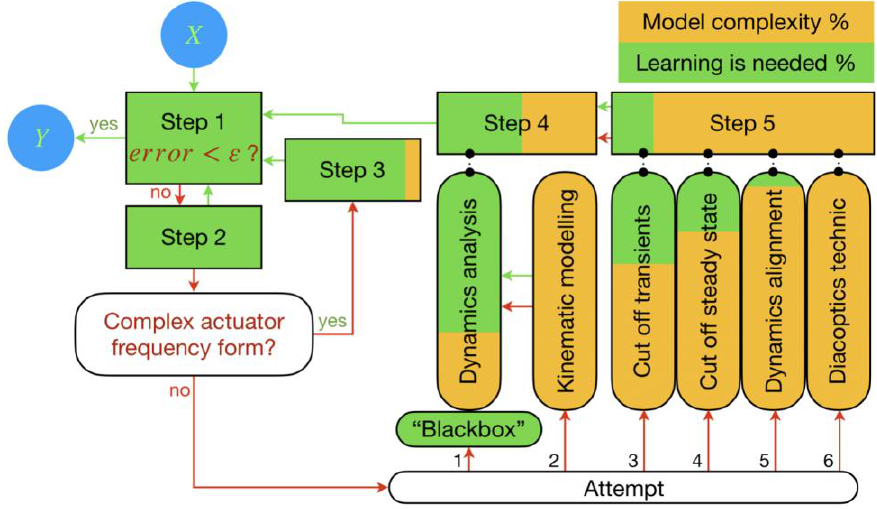
Figure 13. The final view of the drilling